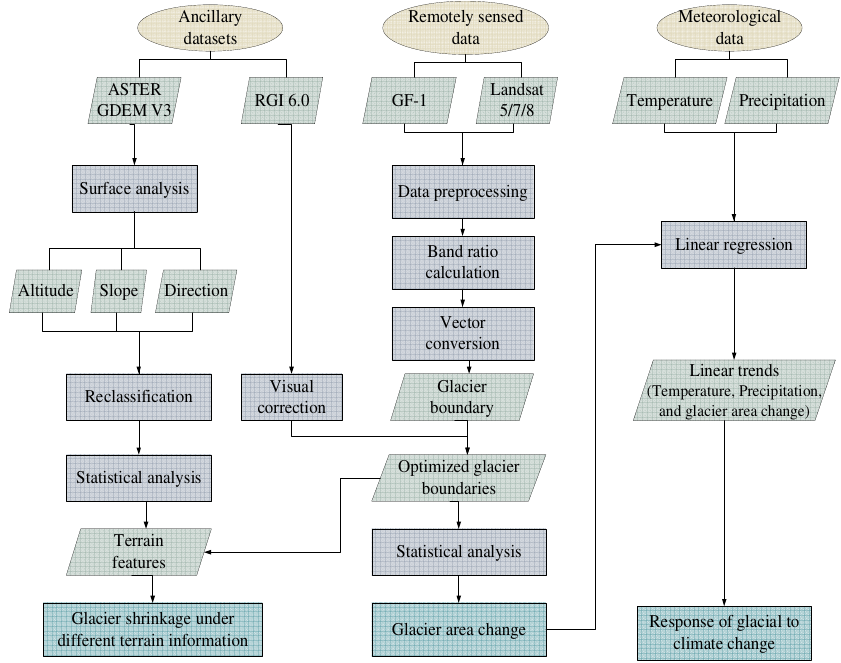
Figure 2. The flow chart of this